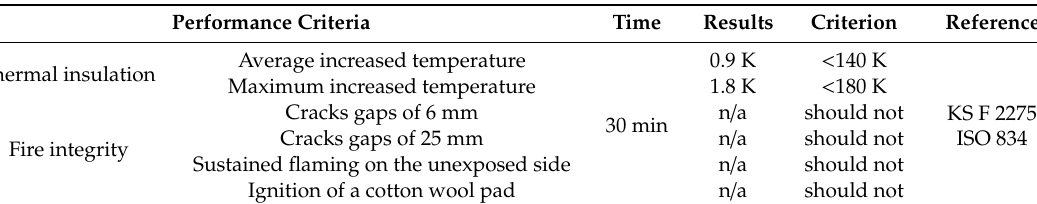
Table 2. Results of the fire resistance test.